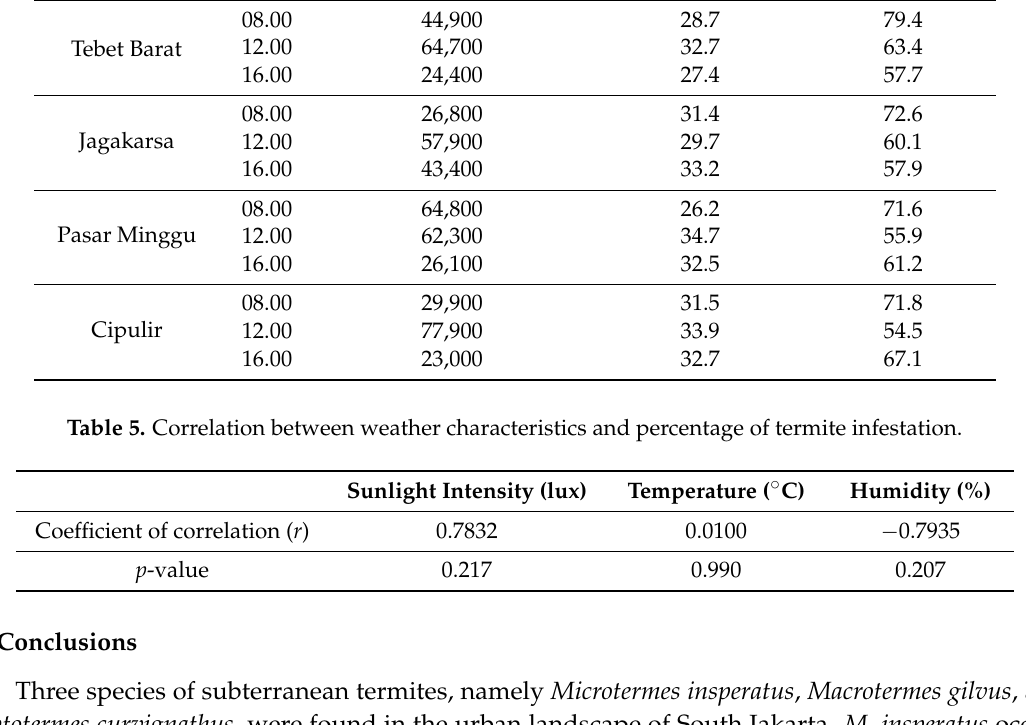
Table 4. Measurement data of temperature, light intensity, and humidity at four residences in South Jakarta. Residential Time